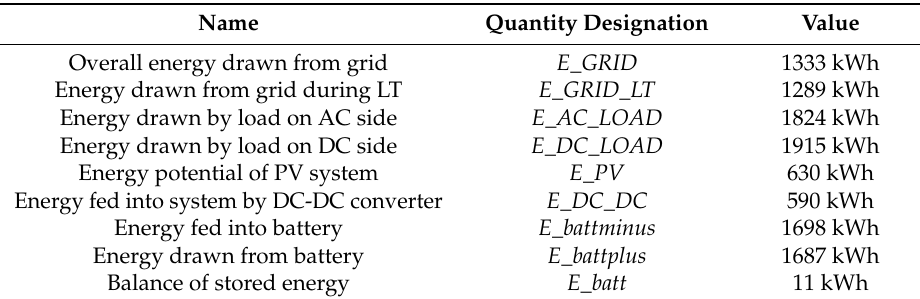
Table 5. Resulting energy balances for scenario A.